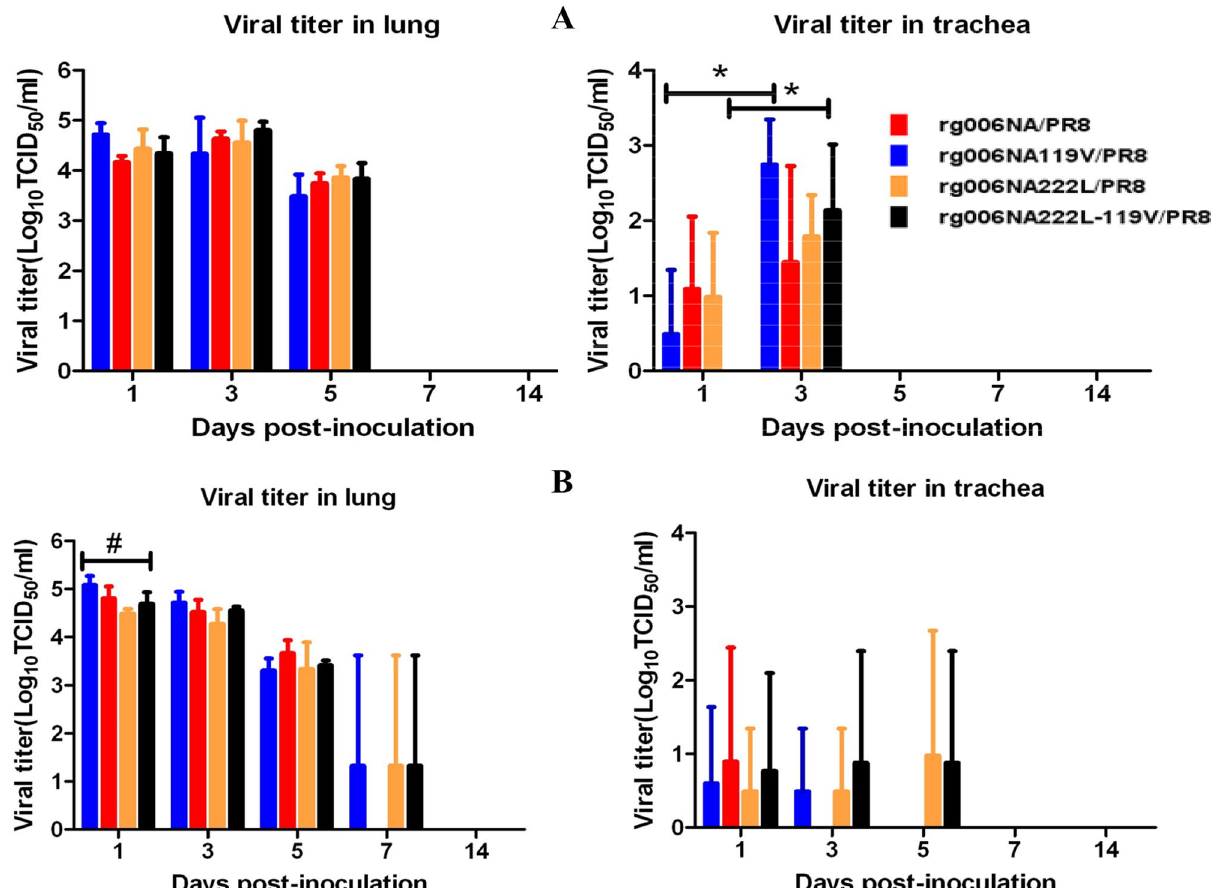
Figure 3. Replication of H7N9/PR8 recombinant viruses in the respiratory tract of mice. C57BL/6 mice (n = 3/ time-point) were inoculated intranasal with 10 4 TCID 50 ( A ) or 10 5 TCID 50 ( B ) of the H7N9/PR8 recombinant viruses. Mice were euthanized at 1, 3, 5, 7 and 14 dpi. Viral titers in the lung (lu) or tracts (tr) were determined on MDCK cells. *P < 0.05. # P <